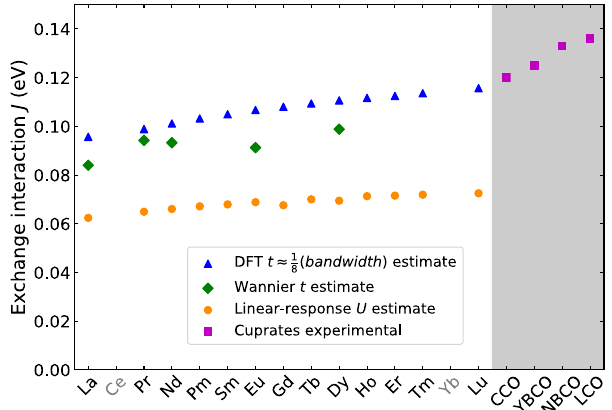
FIG. 5. Exchange interaction of R NiO 2 . Blue triangles show the exchange interaction J calculated by 4 t 2 =U , where t is estimated × bandwidth of the Ni 3 d x 2 − y 2 band. Green diamonds show by 1 8 the exchange interaction J calculated by 4 t 2 =U , where t is the Wannier downfolding nearest-neighbor hopping for the Ni 3 d x 2 − y 2 band. Orange circles are the exchange interaction calculated by 4 t 2 =U , where t is estimated by 1 Ni 3 d x 2 − y 2 band and U is calculated by the linear-response method [51]. The cuprate exchange interactions shown by magenta squares are taken from Ref. [52 –